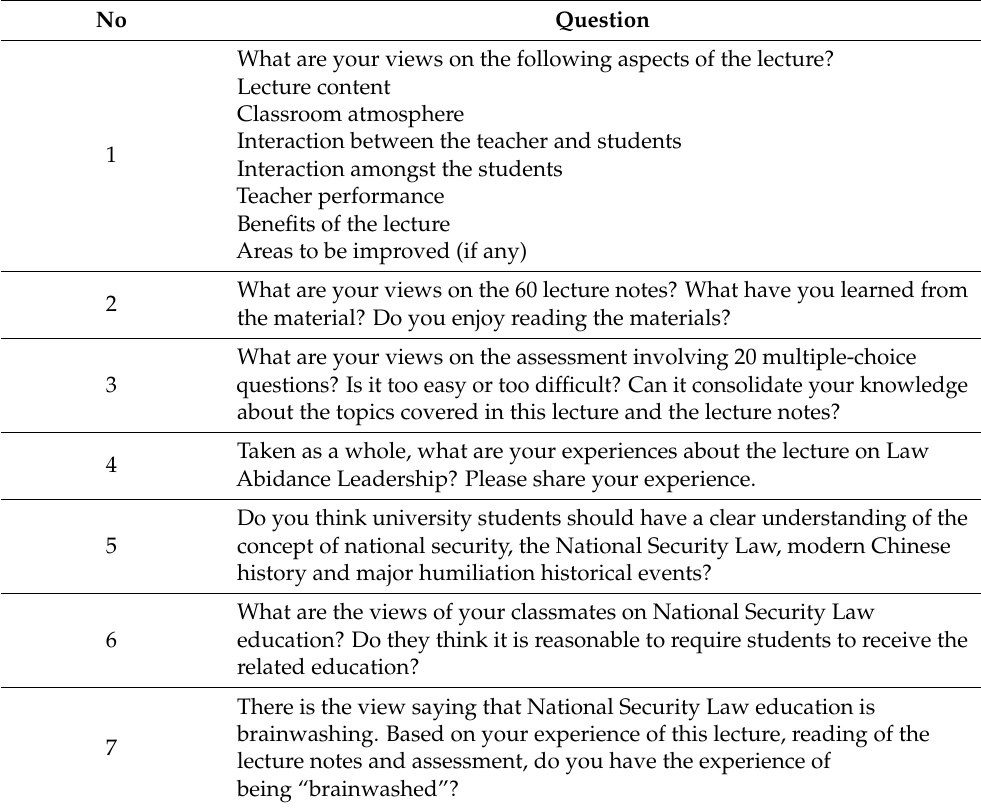
Table 1. Interview guide for the focus group